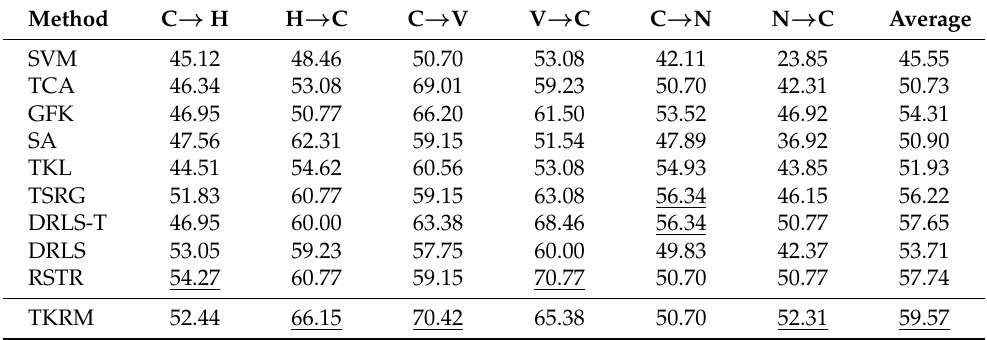
Table 3. The results of cross-database MER experiments in terms of accuracy (%) among CASME II, HS, VIS, and NIR, respectively. The best result in each experiment is